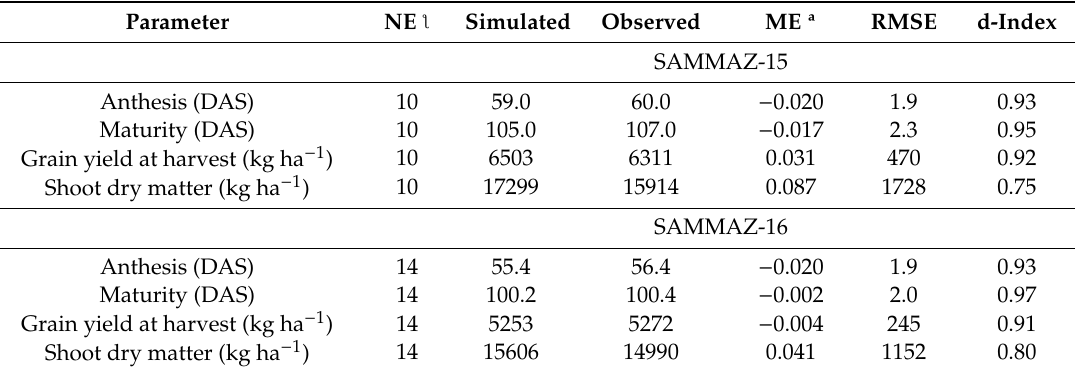
= number of experiments, ª Mean error = (simulated-observed) / observed, DAS = days after sowing, d-index = Willmott index of agreement [38] ranging from 0 to 1, 1 being perfect Table 4. Grain yield (kg ha −1 ) of 30-year (1985–2014) seasonal analysis (model application) for SAMMAZ-15 and SAMMAZ-16 using different sowing windows at SS, SGS, and SGS in Nigeria.